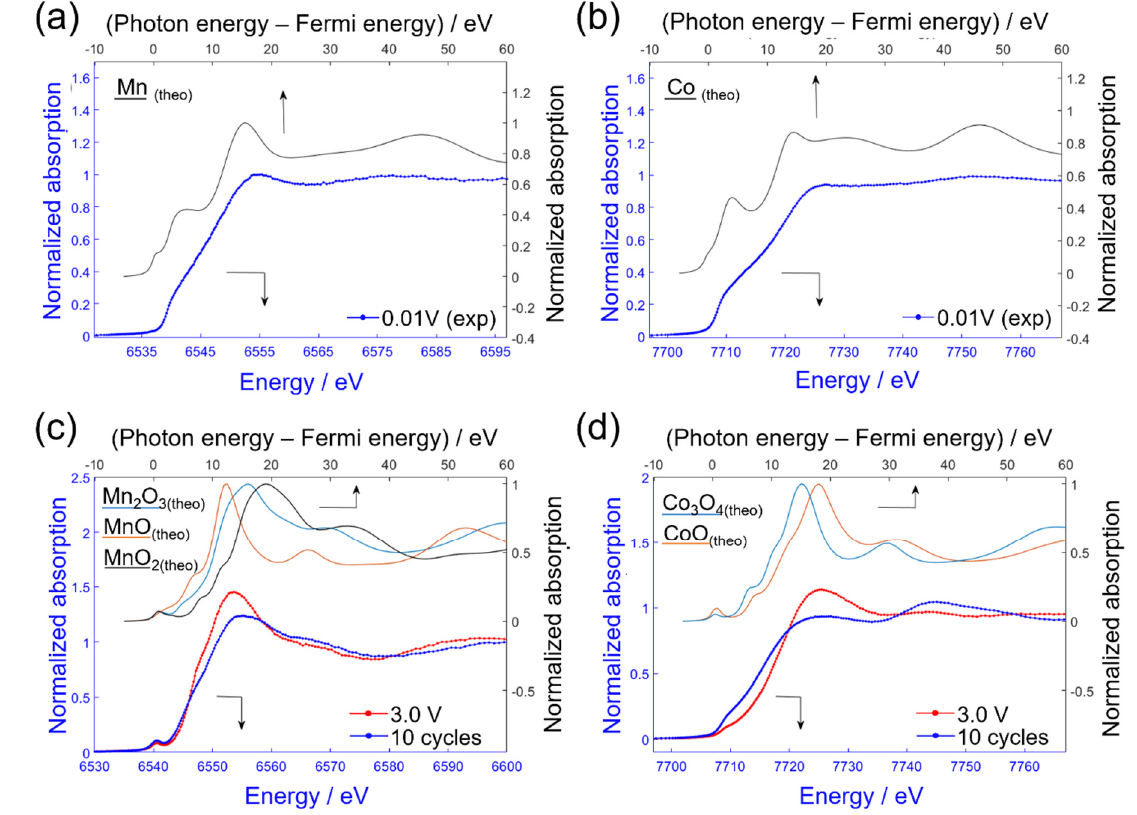
Figure 9. ( a , b ) Comparison of the experimental and calculated XANES spectra at ( a ) the Mn K-edge and ( b ) Co K-edge at 0.01 V. In both cases the experimental XANES spectra are compared with theoretical XANES spectra calculated for metallic Mn or Co. ( c , d ) Comparison of the experimental XANES spectra recorded for the ex situ samples charged to 3.0 V and after 10 cycles at the ( c ) Mn K-edge and the ( d ) Co K-edge with theoretical XANES spectra calculated for various manganese and cobalt oxide references, i.e., MnO, Mn 2 O 3 , and MnO 2 as well as CoO and Co 3 O 4 , respectively.